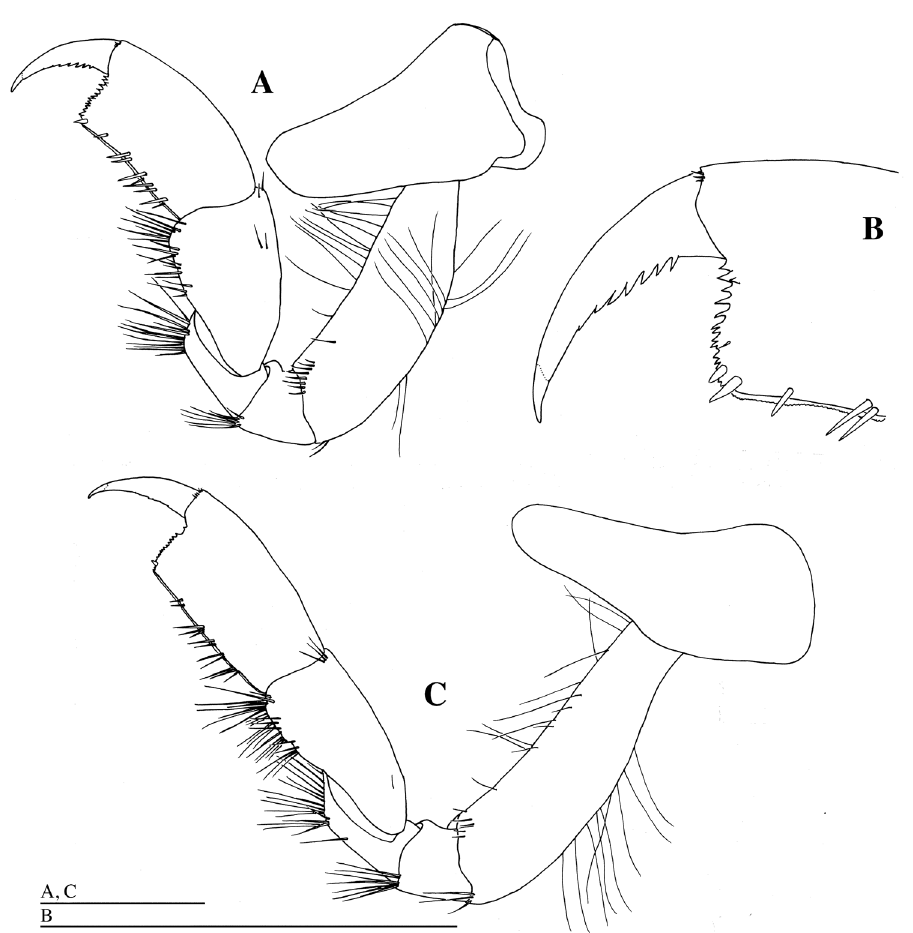
Figure 10. Epimeria abyssalis sp. n., paratype female (KMNH IvR 500907): A left pereopod 1, lateral B distal part of propodus and dactylus of left pereopod 1, lateral C left pereopod 2, lateral. Scale bars: 1